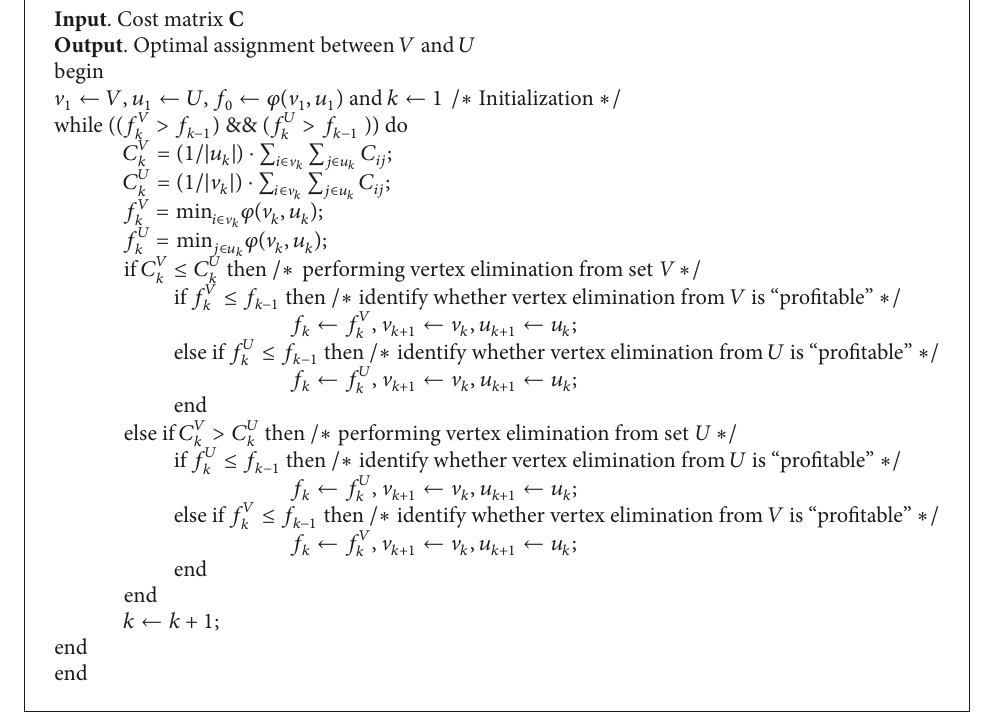
Algorithm 6: GBH hungarian algorithm.